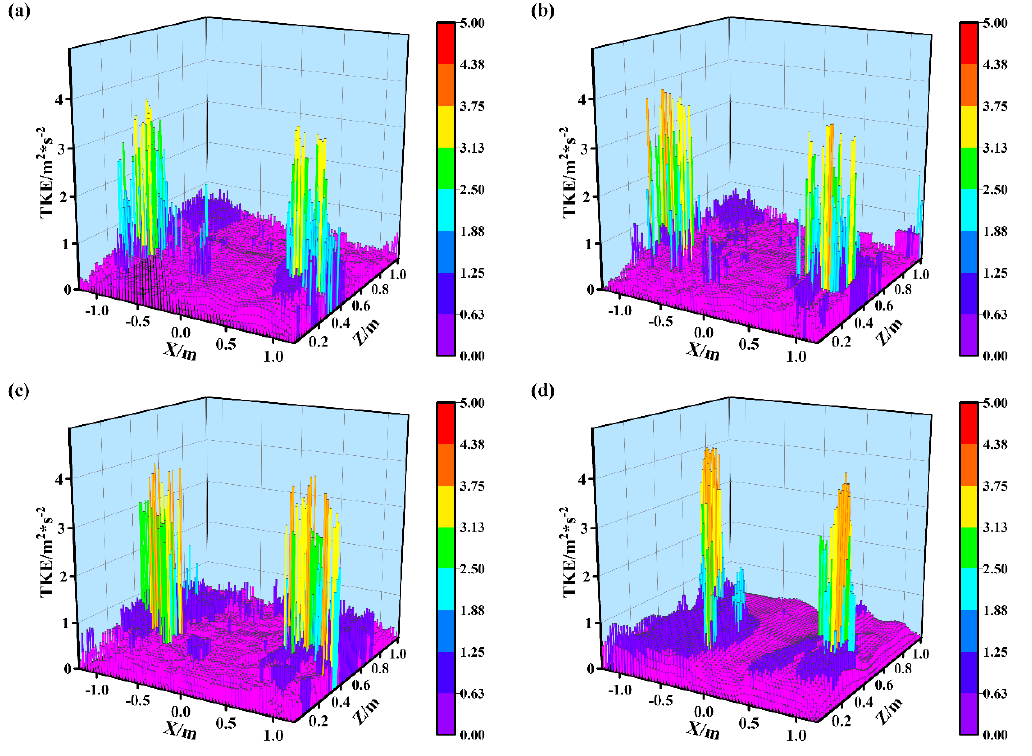
Figure 7. TKE distribution on y = 2.5 m section, ( a ) injection velocity 160 m/s; ( b ) injection velocity 180 m/s; ( c ) injection velocity 200 m/s; ( d ) injection velocity 220 m/s.